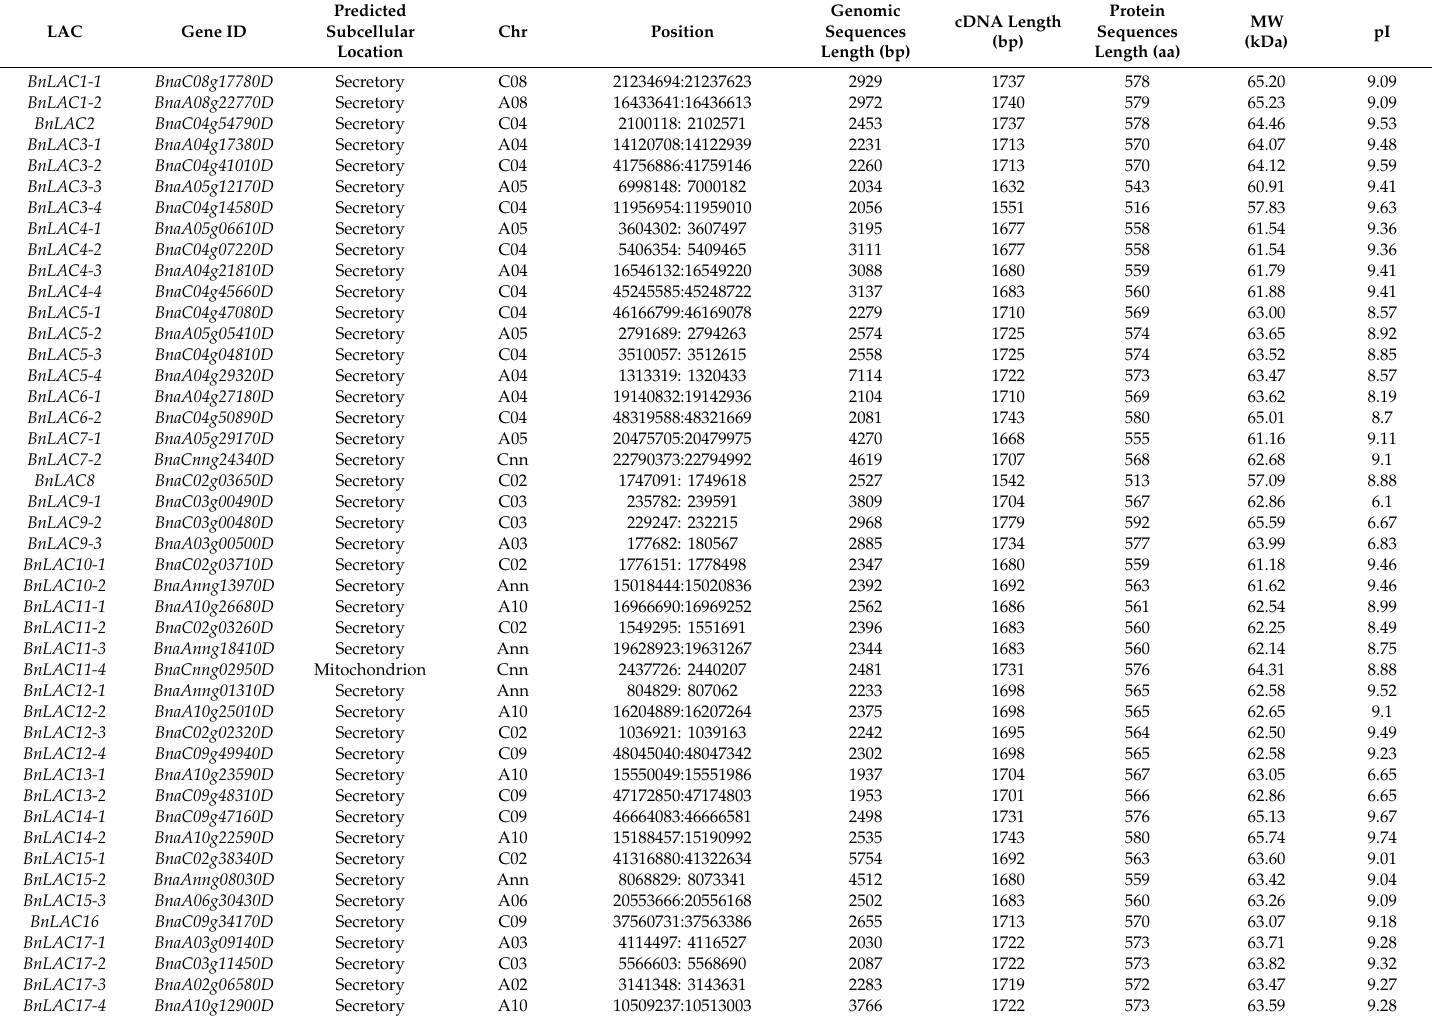
Table 1. Characterization of BnLACs identified in B. napus